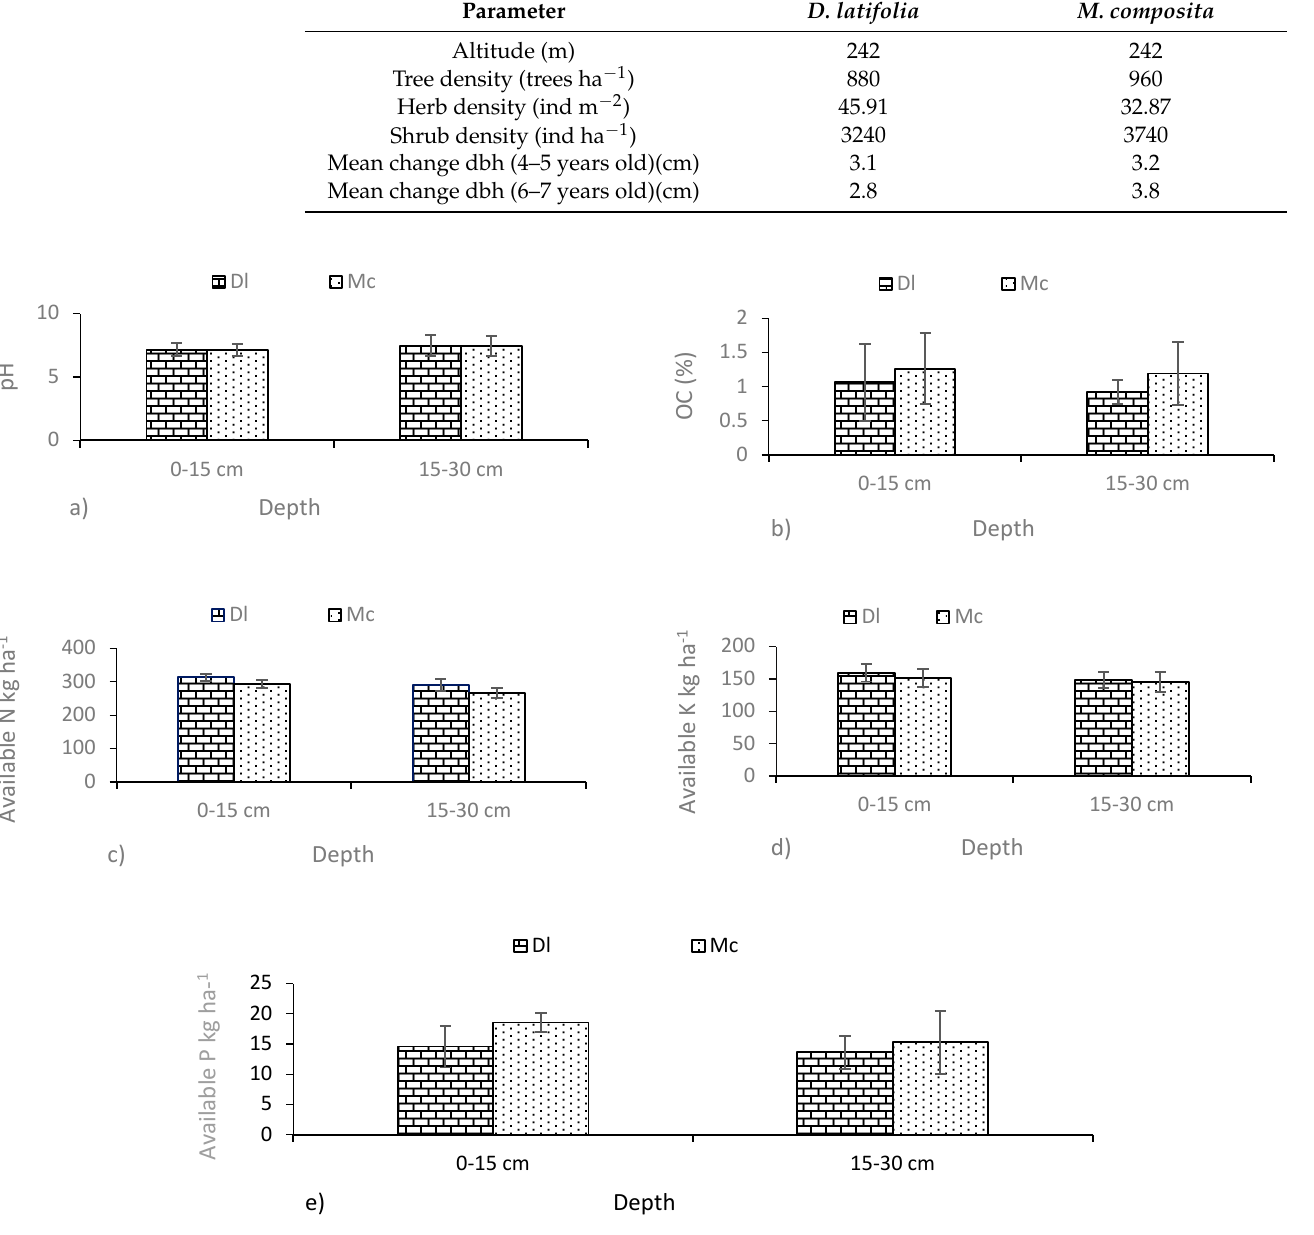
Figure 2. Chemical properties of soil: ( a ) soil pH, ( b ) organic carbon, ( c ) available nitrogen, ( d ) available potassium, ( e ) available phosphorus. Dl: D. latifolia ; Mc: M. composita.